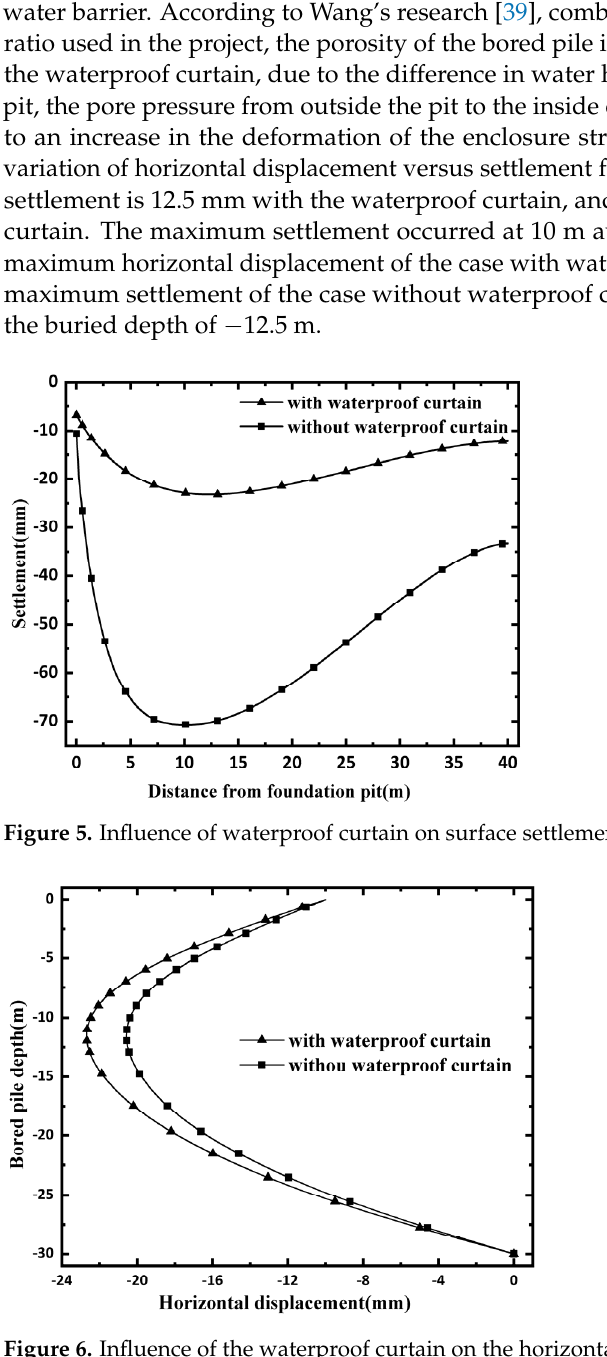
Figure 6. Influence of the waterproof curtain on the horizontal displacement of the pile. The flow network diagram consists of streamlines intersected by lines of equal head. The arrows are Streamlines, which indicate the direction of flow within the seepage zone. The numbers on the contour lines indicate the water head. Figures 7 and 8 show the flow network diagram with and without waterproof curtain.